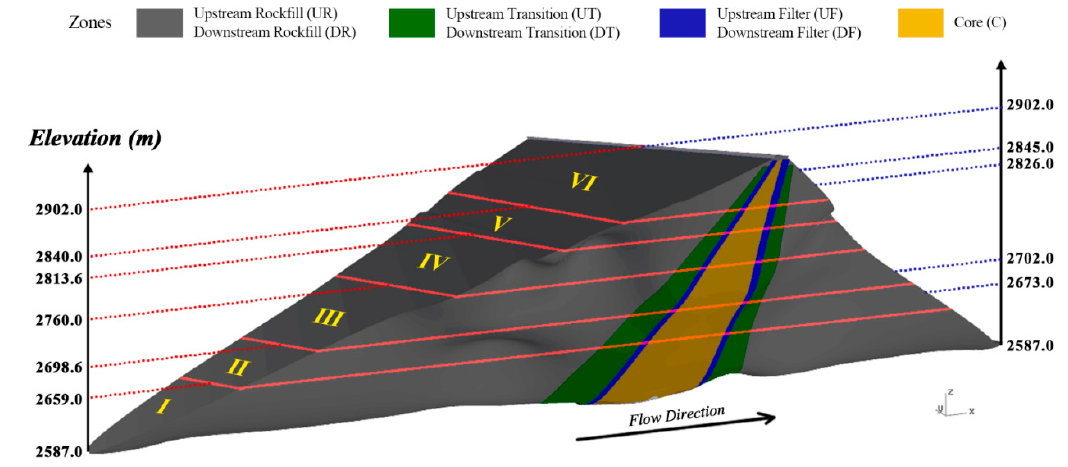
Figure 11. Elevation of each period of the optimal and initial plan.